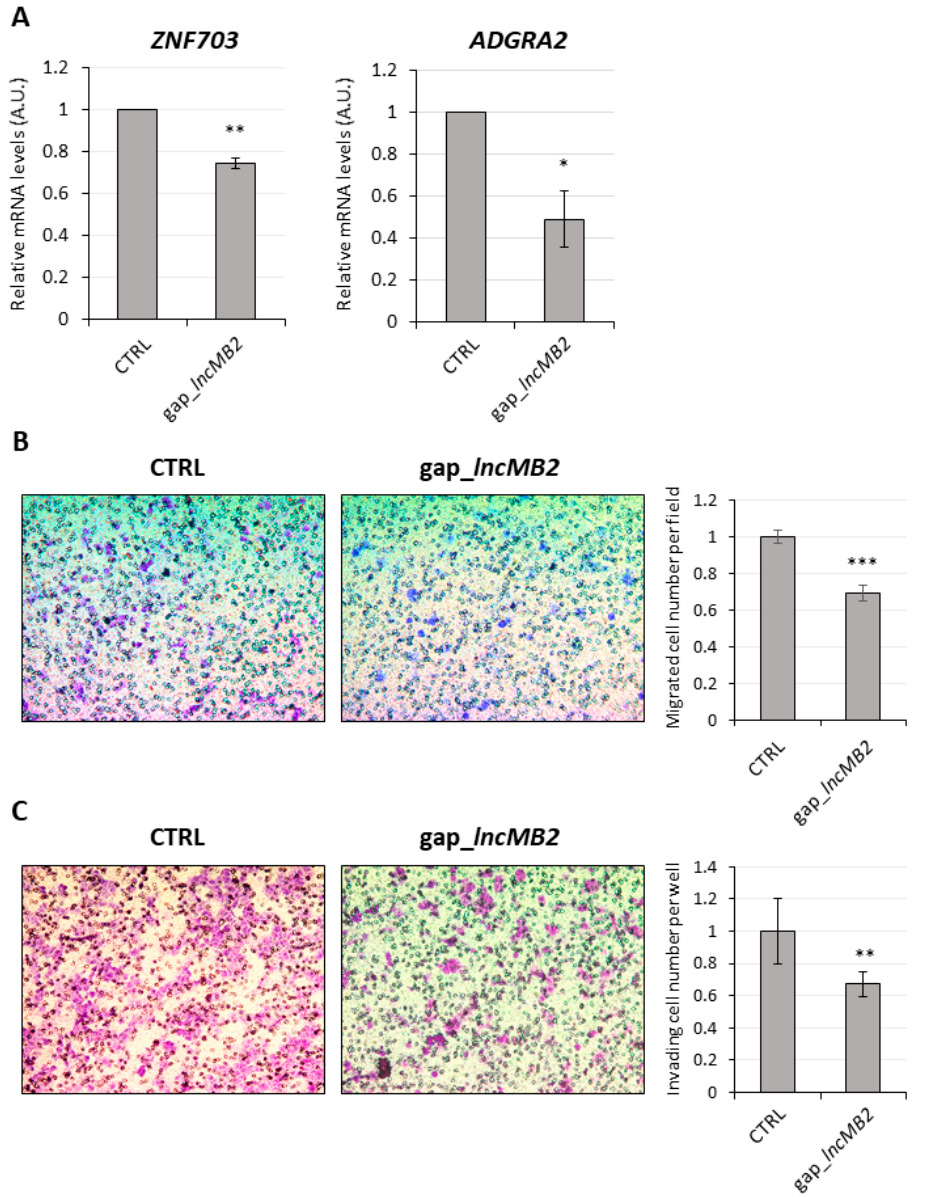
Figure 11. LncMB2 activates ZNF703 and ADGRA2 gene expression and promotes migration/inva- sion of DOX-untreated D283-OMO cells. ( A ) qRT-PCR analysis of ZNF703 (left panel) and ADGRA2 (right panel) expression in DOX-untreated D283-OMO cells upon knock down of lncMB2 , compared to control transfected cells (CTRL), set as 1. Data (means ± SEM) are expressed in arbitrary units (A.U.) and are relative to ATP5O mRNA. N = 4, * p ≤ 0.05, ** p ≤ 0.01 (two-tailed Student’s t -test). ( B ) Left panel: brightfield visualization of crystal violet-stained DOX-untreated D283-OMO migrating cells upon depletion of lncMB2 . Scramble LNA GapmeR-transfected cells were used as a control. Magnification 10×. Right panel: cells were counted by ImageJ in 9 view-fields/membrane and quan- tified in the histogram. Data (means ± SEM) are expressed as number of migrated cells. N = 3, *** p ≤ 0.001 (two-tailed Student’s t -test). ( C ) Left panel: brightfield visualization of crystal violet-stained DOX-untreated D283-OMO invading cells upon lncMB2 depletion. Details as in B. Magnification 10×. Right panel: quantification of invading cell number was determined by colorimetric assay. N = 3, ** p ≤ 0.01 (two-tailed Student’s t -test).